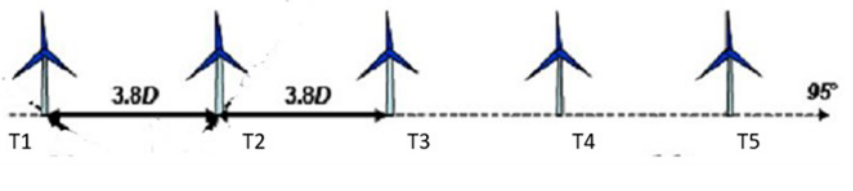
Figure 7. EWTW’s layout.